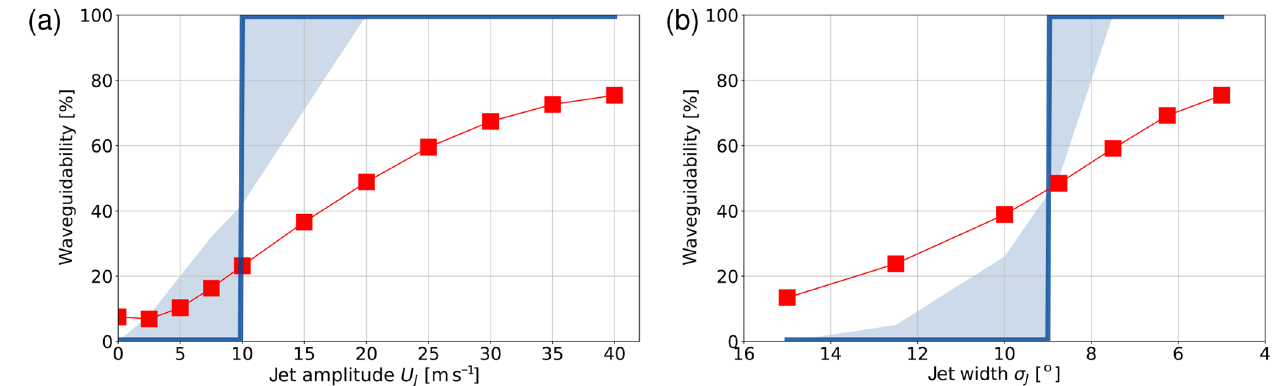
Figure 6. Dependence of waveguidability W on (a) jet strength U J (with σ J = 5 ◦ kept fixed) and (b) jet width σ J (with U J = 40ms − 1 kept fixed). The red squares (connected by a thin red line) represent the values of W diagnosed from the numerical solutions. The solid blue line represents the prediction from ray tracing theory using zonal wavenumber s = 4. The blue shaded area indicates the uncertainty of the ray tracing prediction associated with the fact that the numerical solution does not have a fixed single zonal wavenumber (see text for details).